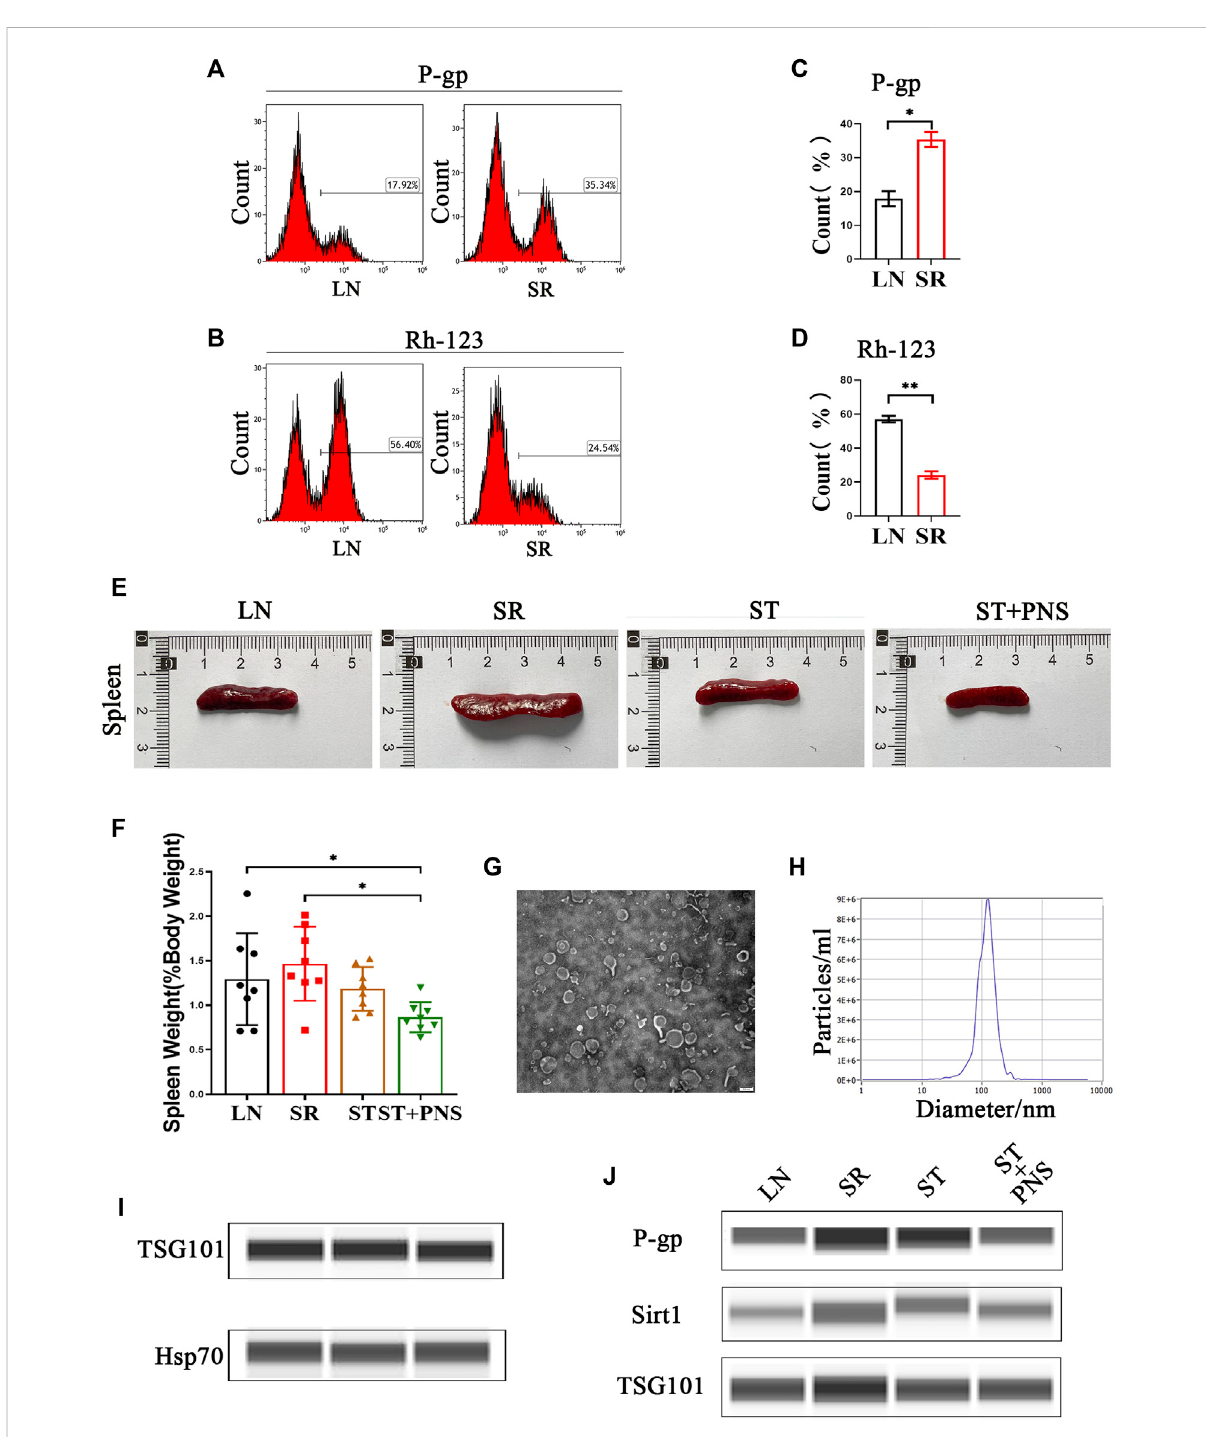
FIGURE 1 Validation of the SR-LN model and differential information expression of exosomes within the four groups. (A – D) Flow cytometry was used to detect P-gp expressionand Rh-123 accumulation in splenic lymphocytes. (E) Imagesof one randomly selected mouse spleenper group and (F) The spleenindexofeachgroupofmice. (G) Themorphologyandstructureofexosomeswerephotographedbytransmissionelectronmicroscopy(scale bar 200 nm). (H) The particle size of the exosomes was detected by NTA. (I) Detection of the exosome markers TSG101 and Hsp70 by capillary immunoassays. (J) Capillary immunoassay analysis of exosome Sirt1 and P-gp protein expression in splenic Lyme-Exos extracted from each group. TSG101 is an exosome marker protein that acts as an internal reference. All data are expressed as the mean ± standard deviation from independent groups, *p < 0.05, ** p <